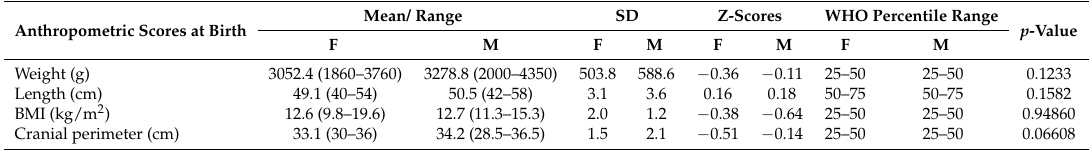
Table 4. Descriptive analysis of anthropometric scores at birth in the sample and comparison to the reference